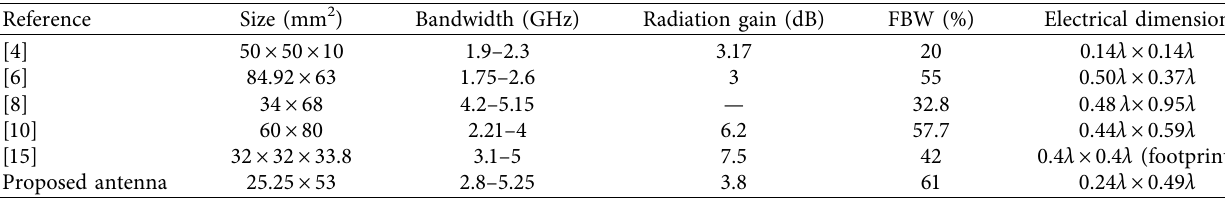
Figure 16: Radiation H plane of the proposed antenna. Table 5: Performance comparison of bow-tie